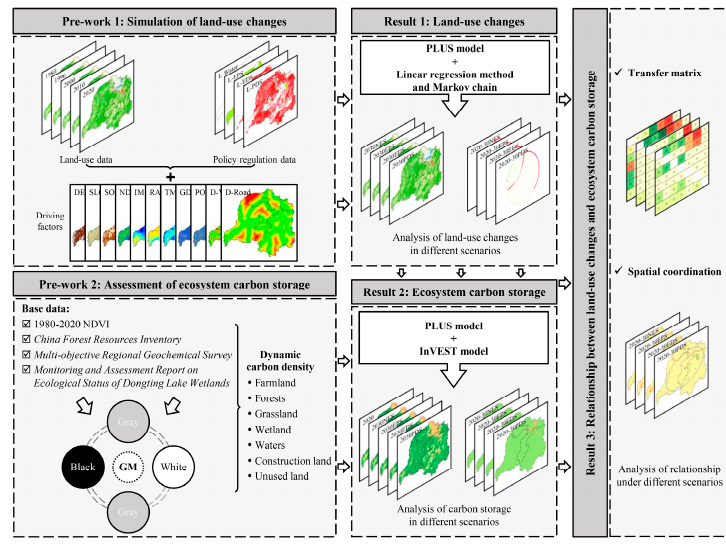
Figure 2. Flowchart of the methodology and analysis in this study.